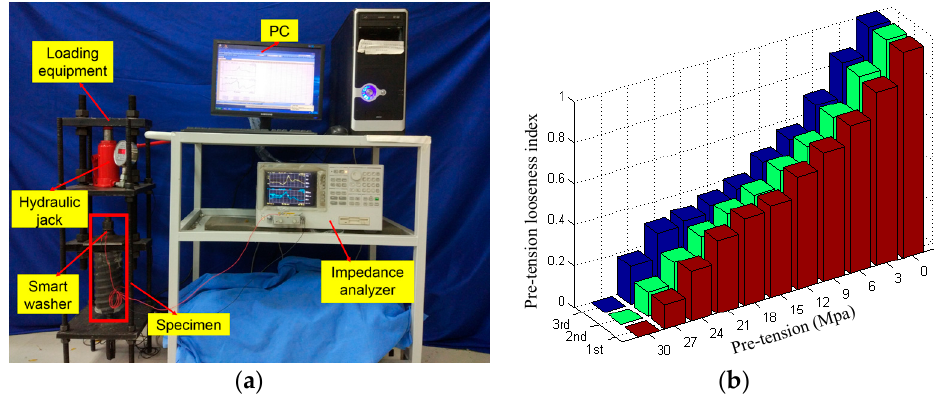
Figure 27. ( a ) The experimental setup; ( b ) the normalized RMSD-based rock bolt looseness indices of three repeating experiments [74].